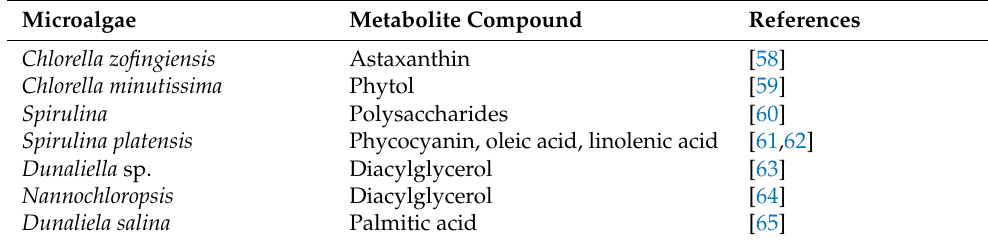
Table 3. Metabolite extracted from different microalgal biomass.